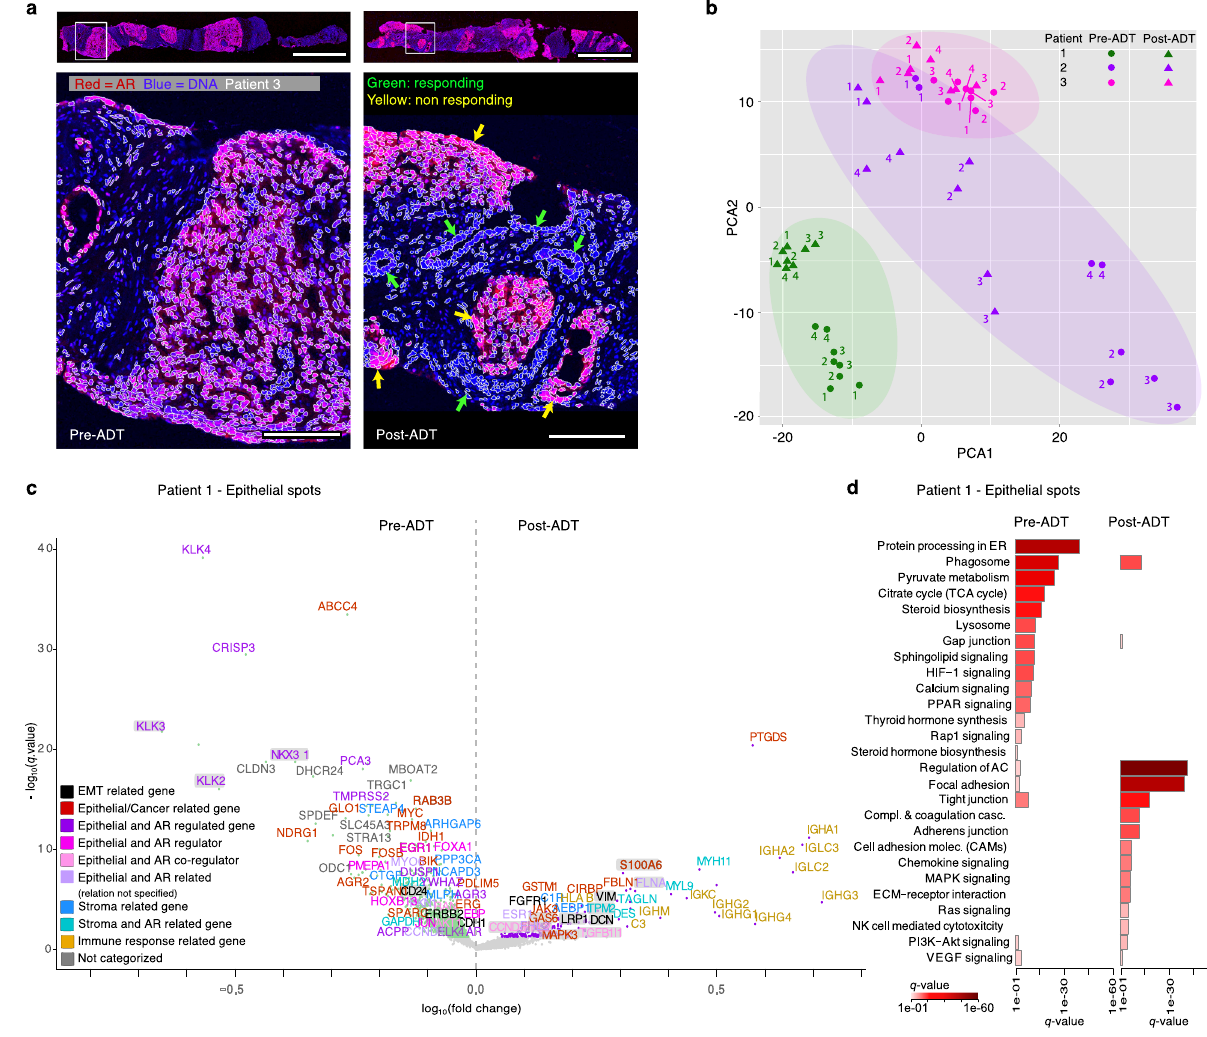
Fig. 2 | Overview of AR activity and bulk analysis results pre- versus post-ADT. a NuclearARactivitypre-andpost-ADTidenti fi esrespondingandresistantprostate cancercellspost-ADT(greenandyellowarrows,respectively).Thescalebarsinthe upper panels are 1mm, in lower panels 200 µ m. b Principal component analysis of pseudo- bulked spots per needle biopsy pre- and post-ADT, after rlog transforma- tion. Source data is provided as Source Data fi le. c DGE analysis (Welch ’ s t -test) of